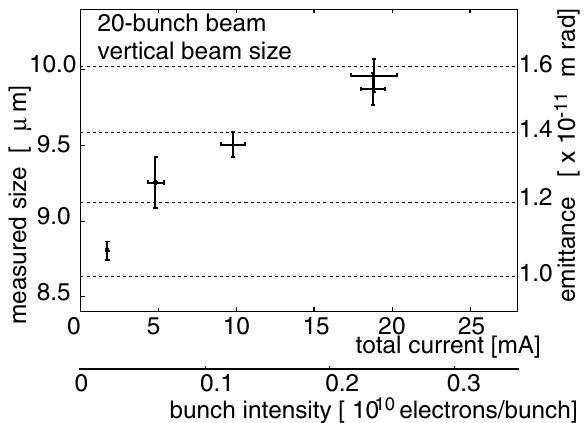
FIG. 10. Vertical emittance of the 20-bunch beam vs the electron current.